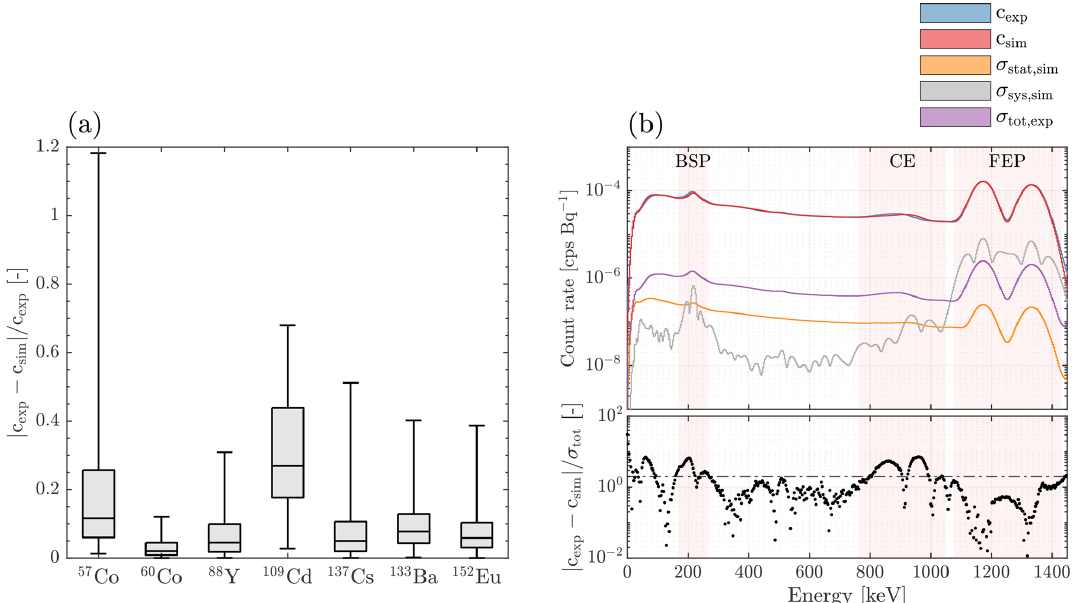
Figure 4. Model accuracy and precision analysis for the summed scintillation crystal spectra. (a) Adjusted box plot characterizing the statistical distribution of the relative spectral error between the experimental and simulated spectral detector response for various radiation sources. The statistical analysis was performed using the Library for Robust Analysis (LIBRA) (Verboven and Hubert, 2005). (b) Uncertainty quantification for the 60 Co spectral detector response. The mean count rates ( c exp , c sim ) together with the corresponding uncertainty estimates ( σ tot,exp , σ stat,sim , σ sys,sim ) using 1SD values are shown both for the experimental and simulated spectral detector response. Distinct spectral regions, i. e. the backscatter peaks (BSP), the Compton edges (CE) as well as the full energy peaks (FEP) are highlighted. The normalized (cid:113) σ 2 tot,exp + σ 2 for a coverage factor of 2 is marked with the horizontal black dash-dotted residual level | c exp − c sim | /σ tot with σ tot := tot,sim